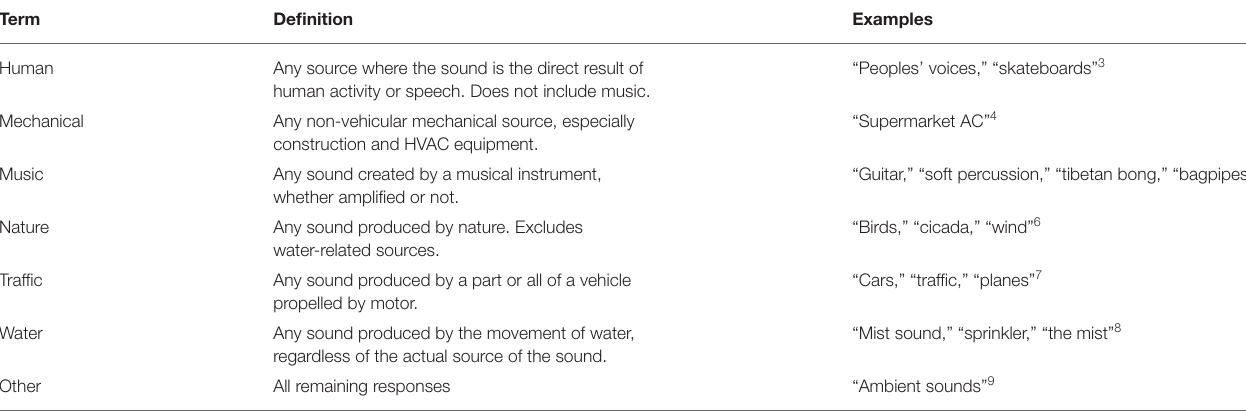
TABLE 3 | Sounds mentioned by respondents were categorized into one of six groups.